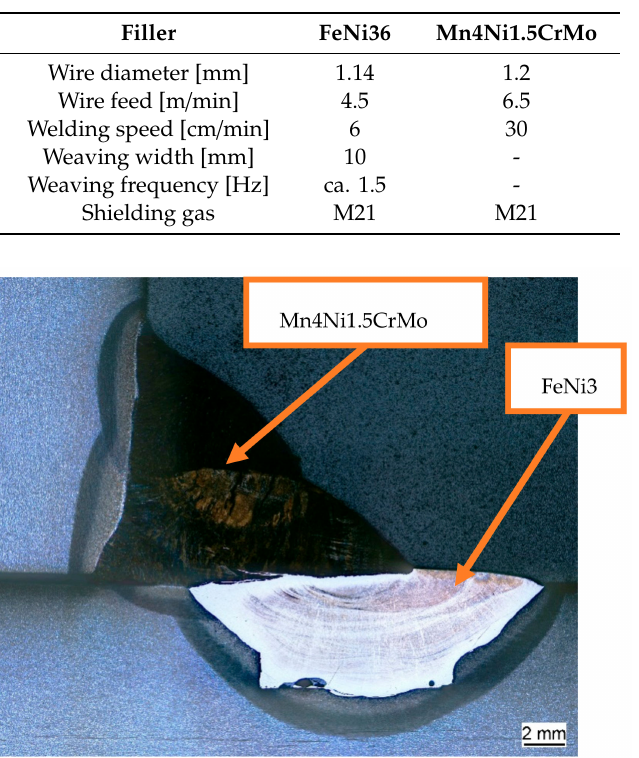
Table 4. Welding parameters for lokal plasticized specimen.